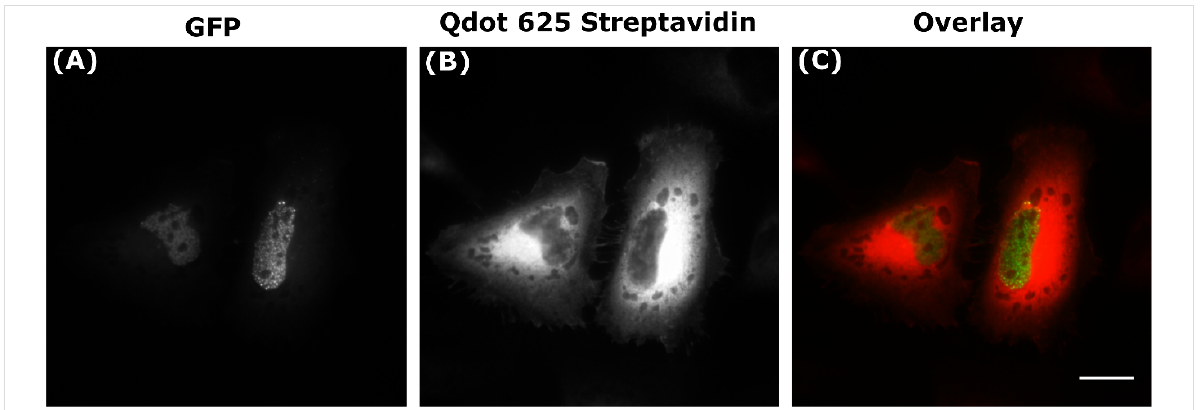
Figure 6: Partial labelling of HIF2 α with Qdot-Streptavidin. Fixed HeLa cells were transfected with EGFP-HIF2 α (A), incubated with a primary anti- GFP biotinylated antibody and Qdot 625 streptavidin conjugate (Qdot-Streptavidin) (B), to produce an overlaid image (C). Scale bar is 20